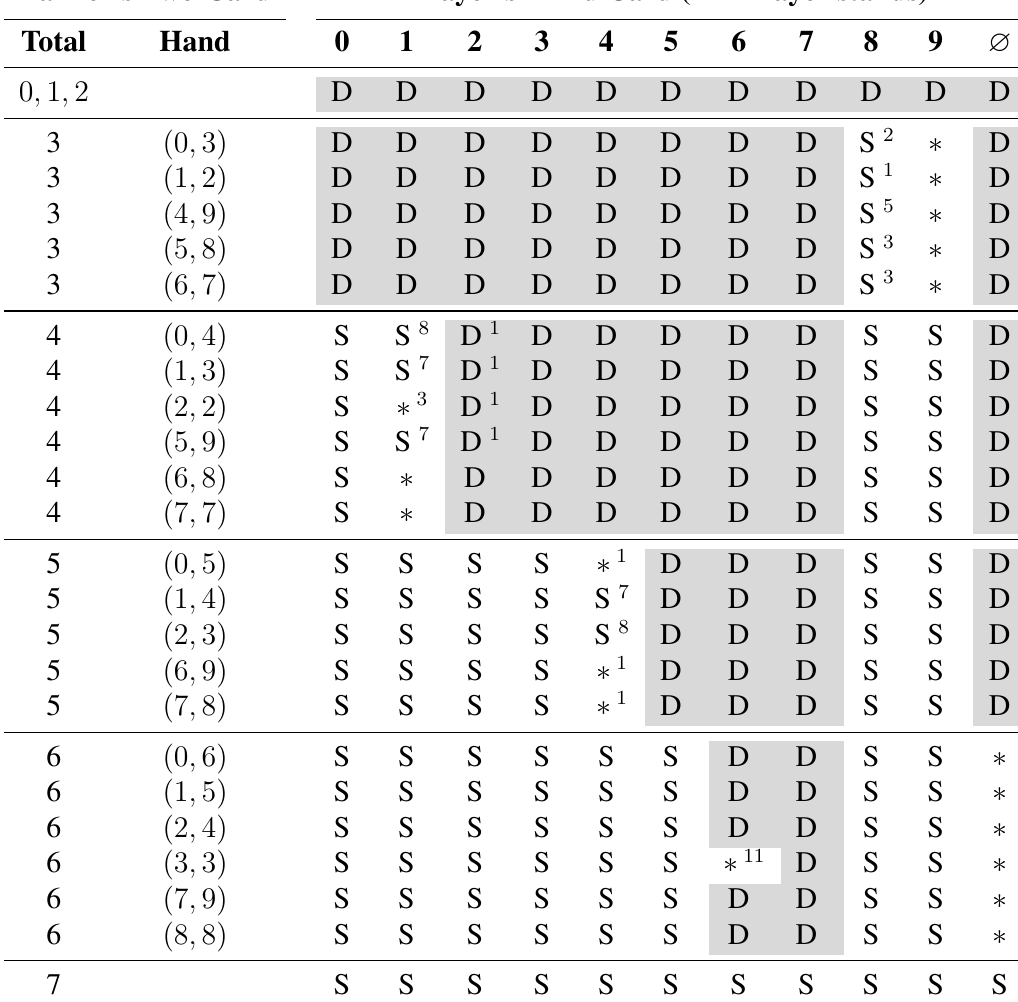
Table 1. Banker’s optimal move (preliminary version) under Model B2 or B3 with d = 6 , = 18 cases indicated by indicated by D (draw) or S (stand), except in the n in which 6 ⇤ it depends on Player’s strategy. Adjustments to the table for other positive integers d are specified by footnotes. Under Model A2 or A3, results are the same as those under Model 11 B2 or B3 with d